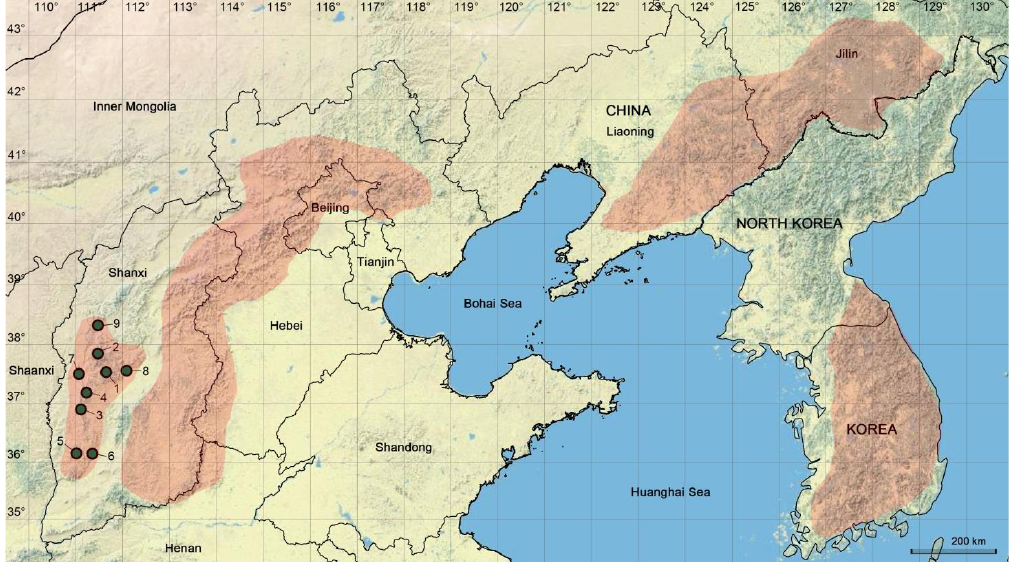
Figure 1. Distribution records of the Pholcus phungiformes species group from the Lüliang Mountains, China. Red shadows from left to right indicate the Lüliang Mountains, the Yanshan–Taihang Mountains, the Changbai Mountains, and the Taebaek Mountains, respectively. 1: P . wenshui sp. nov.; 2: P . jiaocheng sp. nov.; 3: P . luliang sp. nov.; 4: P . zhongyang sp. nov.; 5: P . linfen sp. nov.; 6: P . xiangfen sp. nov.; 7: P . lishi sp. nov.; 8: P . xuanzhong sp. nov.; 9: P . luya .